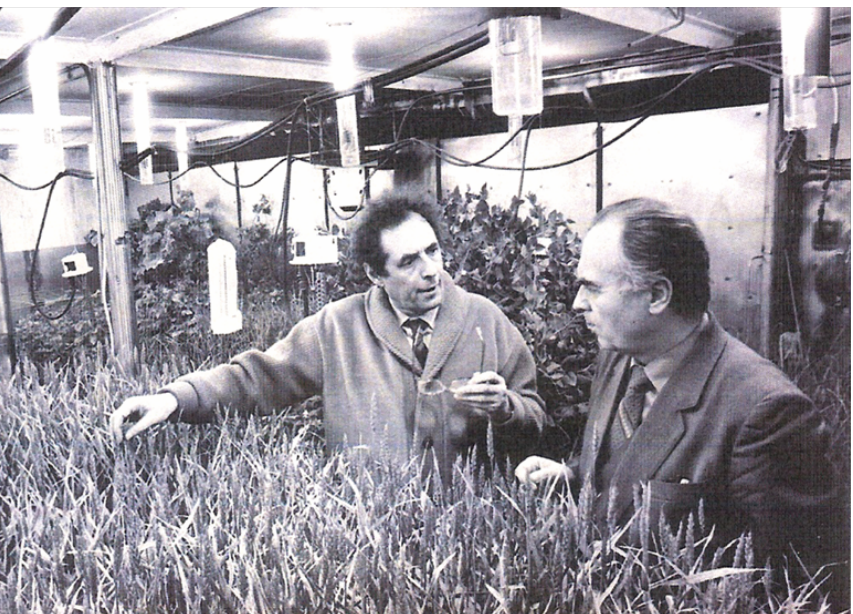
Figure 1. Academician Iosif (Joseph) Gitelson and Professor Genrich (Henry) Lisovsky inside BIOS-3 facility at the Institute of Biophysics